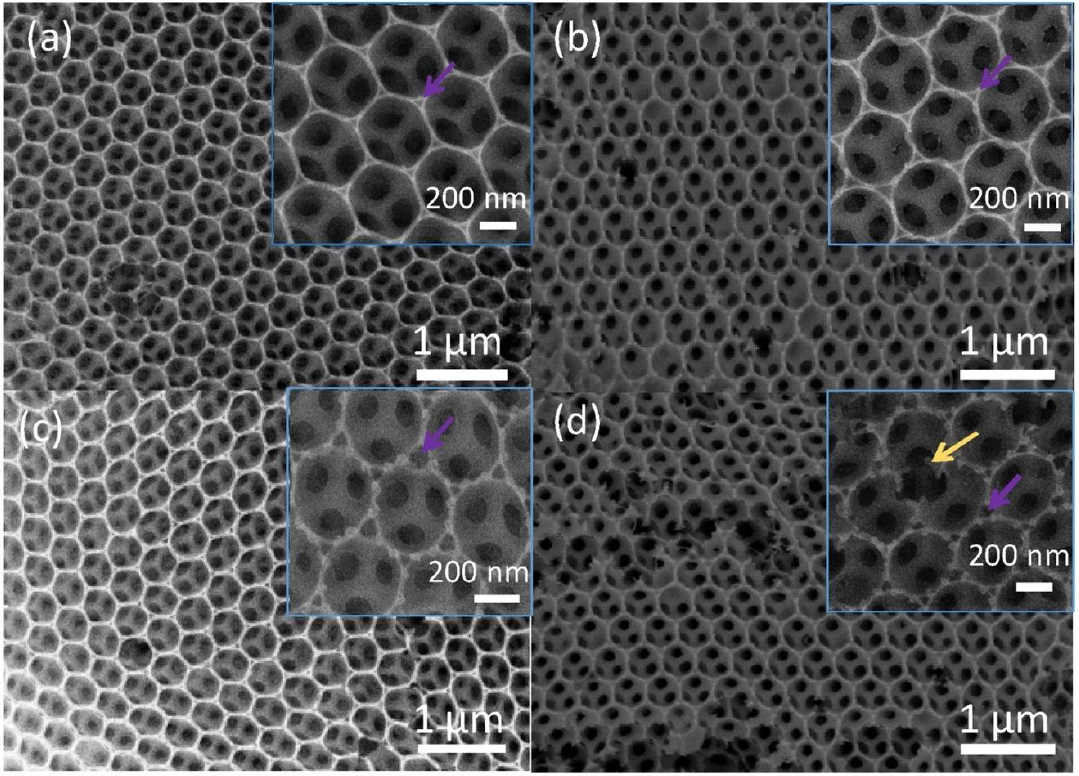
Figure 10. The SEM images of ZnO-Fe 3 O 4 3DIO samples with the Fe / Zn atom ratios of ( a ) 0:10, ( b ) 1:10, ( c ) 2:10, and ( d ) 3:10 samples [135]. Reprint permission was obtained from Elsevier.